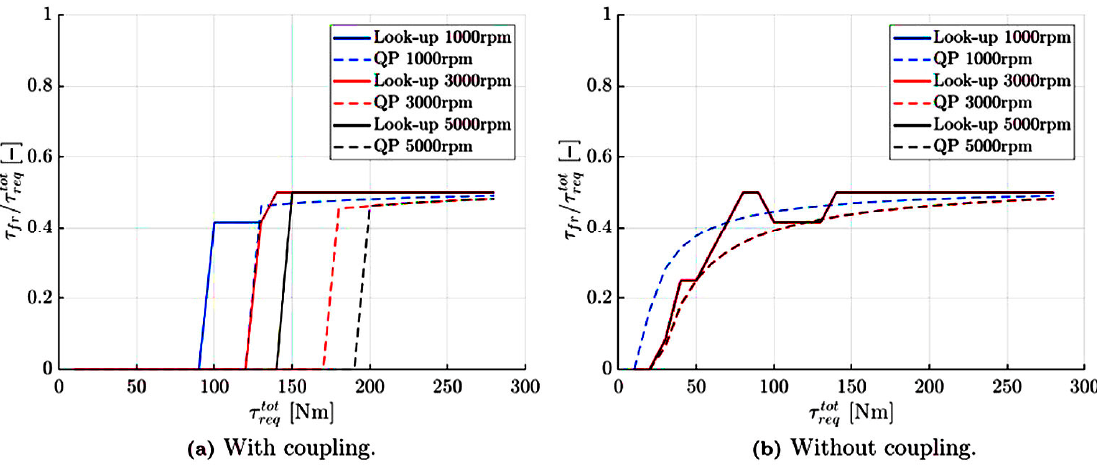
Figure 29. Ratio of forward and total torque distribution for three different engine speeds, comparison of autonomous optimization and QP: ( a ) with clutch and ( b ) without clutch.